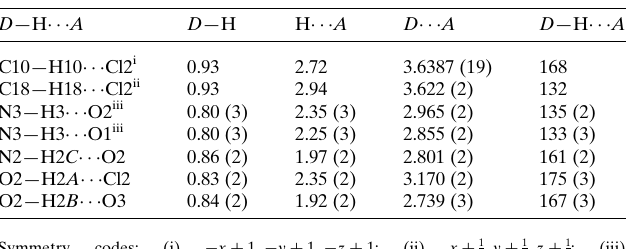
Table 1 Hydrogen-bond geometry (A˚ , (cid:4) ).